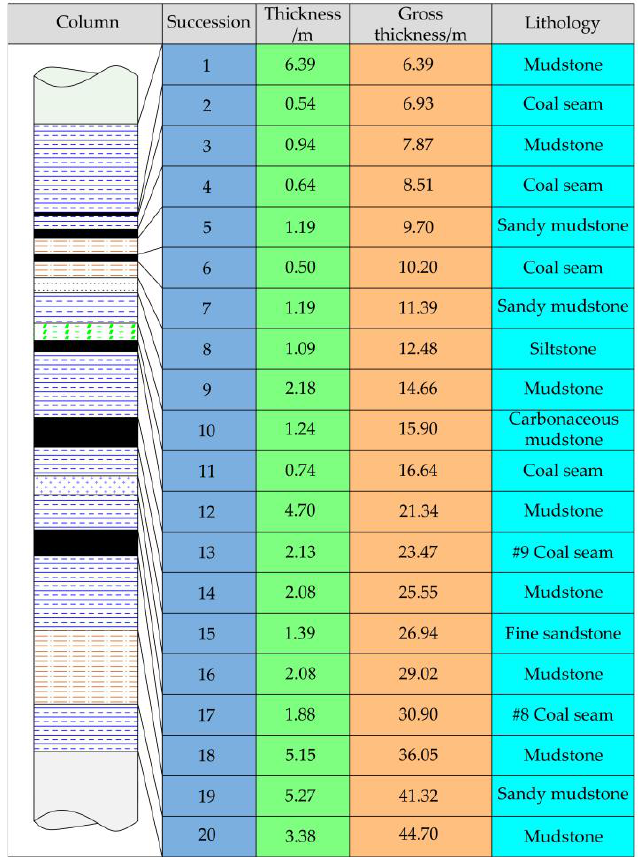
Figure 1. Strata comprehensive column of the study area .